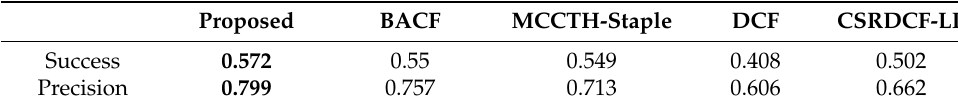
Table 4. Overall Performance Evaluation Results of